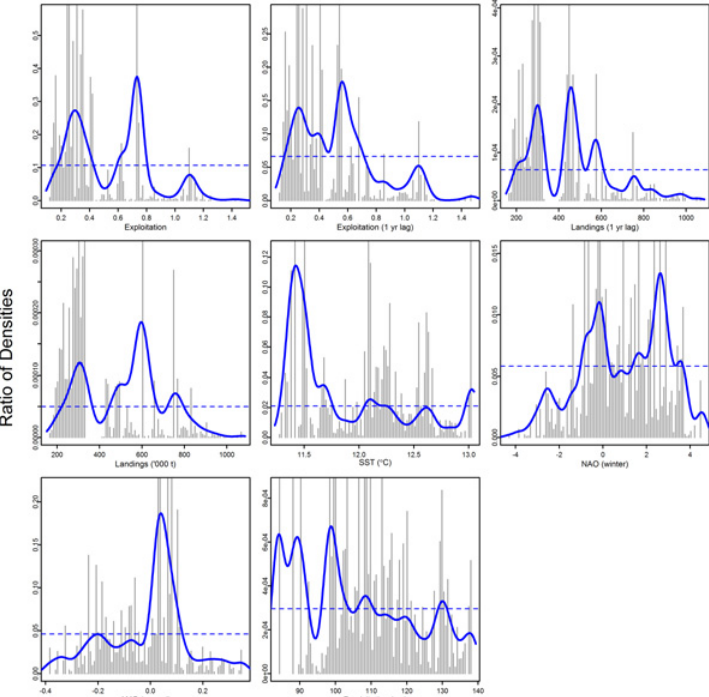
Fig 4. Threshold shifts in the value of aggregated ecological indicators along the gradient of environmental and anthropogenic pressure variables and reflect a rate of change in ecosystem processes. Binned raw importance of splits from random forests for ecological indicator value relative to the pressure variable on the horizontal axis. Density plots (lines) illustrate the estimated importance or turnover rate at any given pressure value, which is estimated as the ratio of the density of split importance to the density of observed predictor values along the predictor gradient. The dashed line indicates where the ratio is 1. Ratios > 1 indicate locations of relatively greater change in community composition, such that peaks in the density plot indicate threshold values for each environmental predictor where ecosystem status is expected to